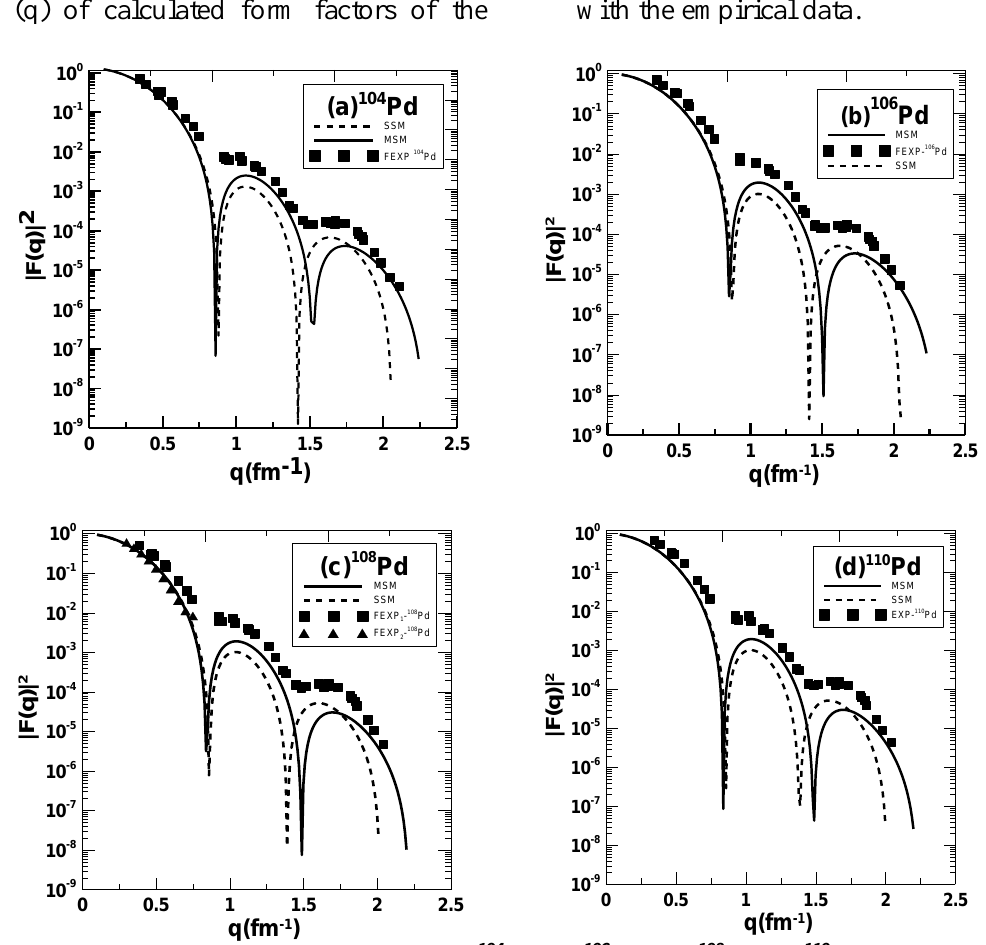
Fig.2: Elastic charge form factor of (a) 104 Pd, (b) 106 Pd, (c) 108 Pd, (d) 110 Pd nucleus using SSM (dashed curves) and MSM (solid curves) are the calculated charge form factors calculated using methods through Eq.(13) in comparison with the experimental data